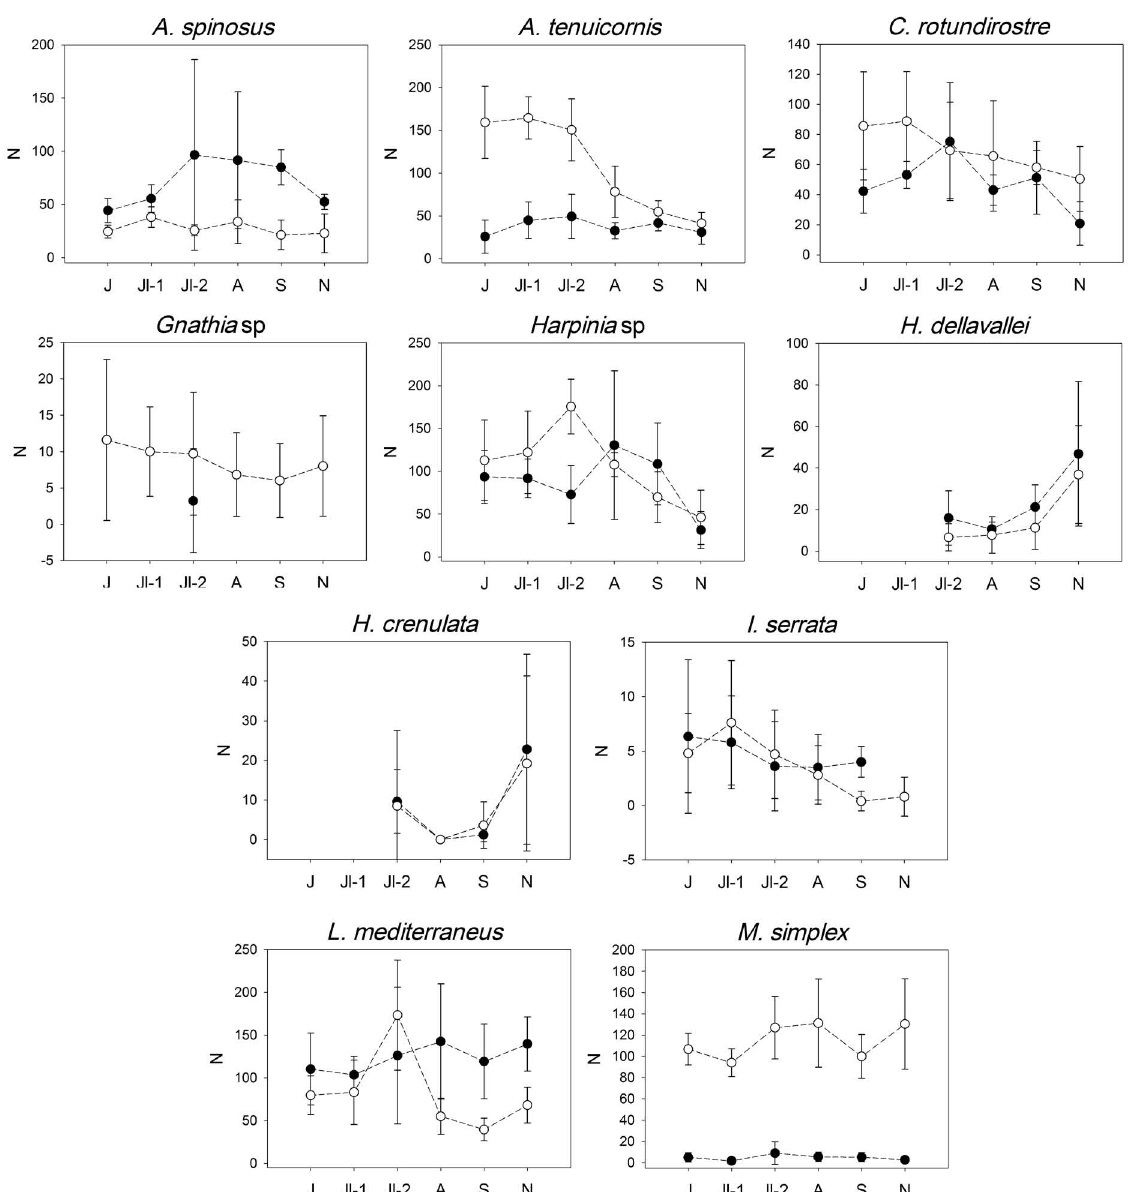
Fig . 7. – Mean (±SD) abundance (N m -2 ) of crustacean species at S1 (black circles) and S2 (open